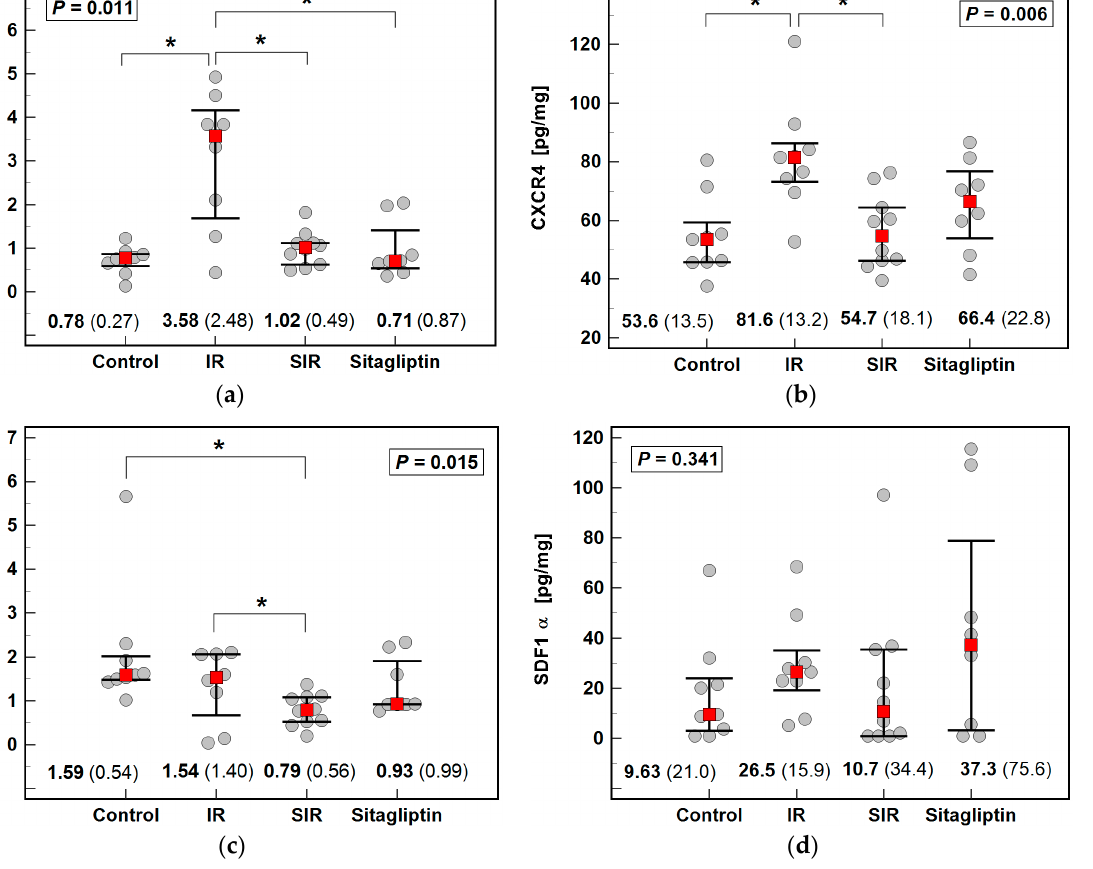
( d ) Figure 3. Effect of IR injury and sitagliptin on PAC1, VPAC1, VPAC2/VIP axis in the liver: ( a ) Pac1 expression; ( b ) Vpac1 expression; ( c ) Vpac2 expression; ( d ) VIP concentration. Data were analyzed using the Kruskal–Wallis H test and are presented as medians with IQR (red squares with whiskers and numbers below dot-plots). Significant ( p < 0.05) differences between groups, identified in post-hoc analysis (Conover test), are indicated by connectors with * symbol. NRQ, normalized relative quantity; IR, ischemia-reperfusion; SIR, sitagliptin pretreatment and ischemia-reperfusion; IQR, interquartile range.